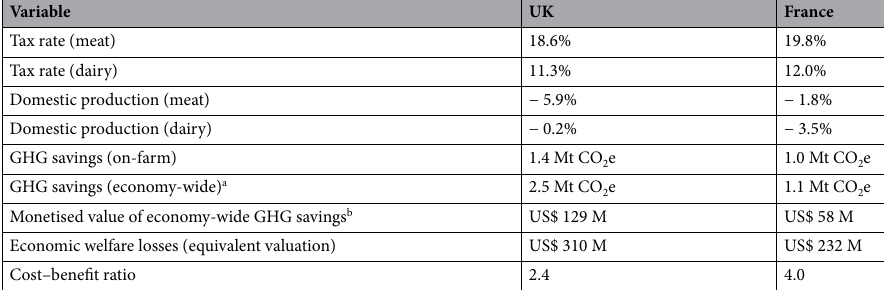
Table 1. Estimated macroeconomic impacts of taxation against the ruminant sector (per year). a Includes indirect effects from interconnected industries (e.g. reduced fertiliser production). b Evaluated at US$52/t CO2 e , the carbon price used to derive the proposed tax rates 31